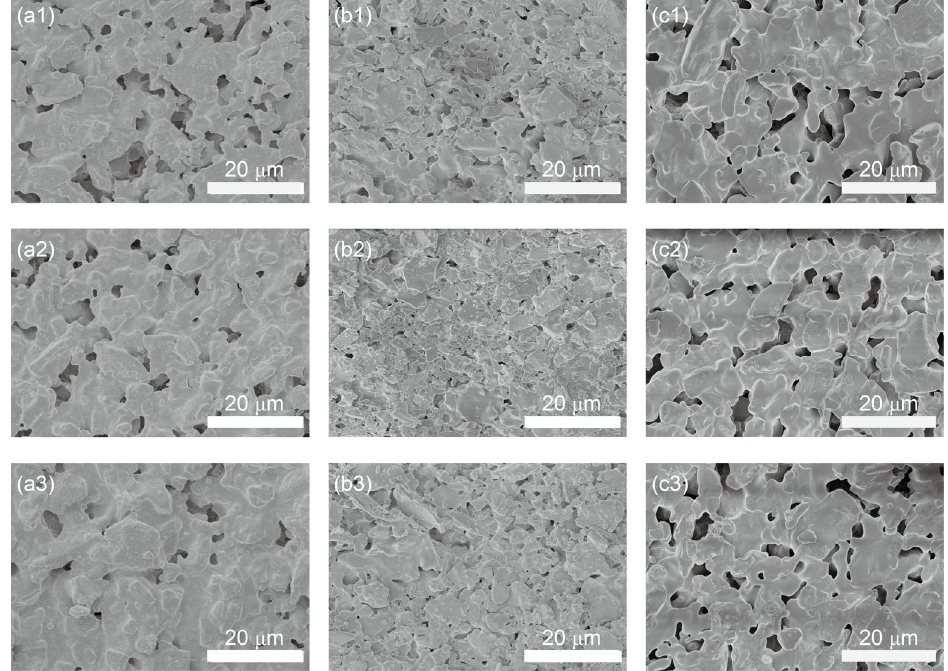
Fig. 2 SEM images of mullite hollow fiber membranes doped with different additives and contents sintered at 1570 ℃ : (a) YSZ, (b) SMP, (c) TiO 2 , (1) 5.0 wt%, (2) 10.0 wt%, (3) 15.0